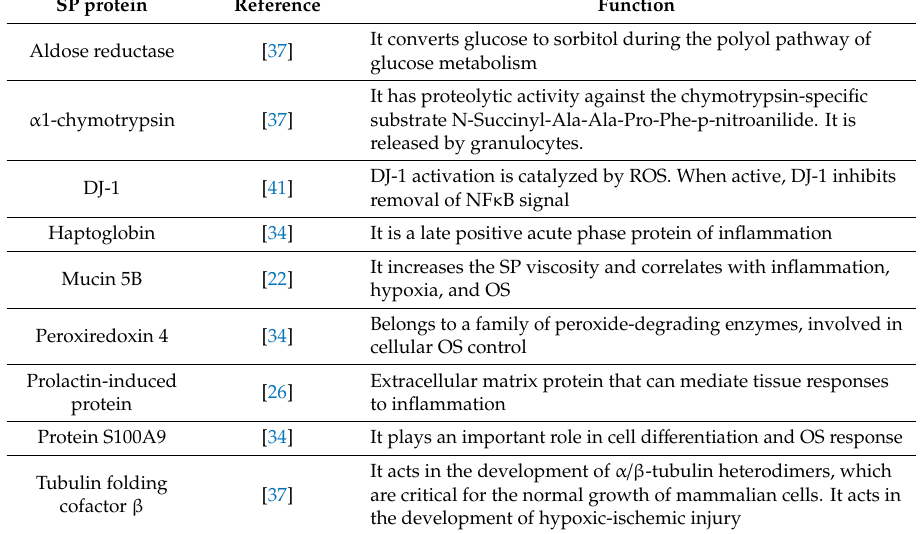
Table 1. Seminal plasma proteins overexpressed in patients with increased oxidative